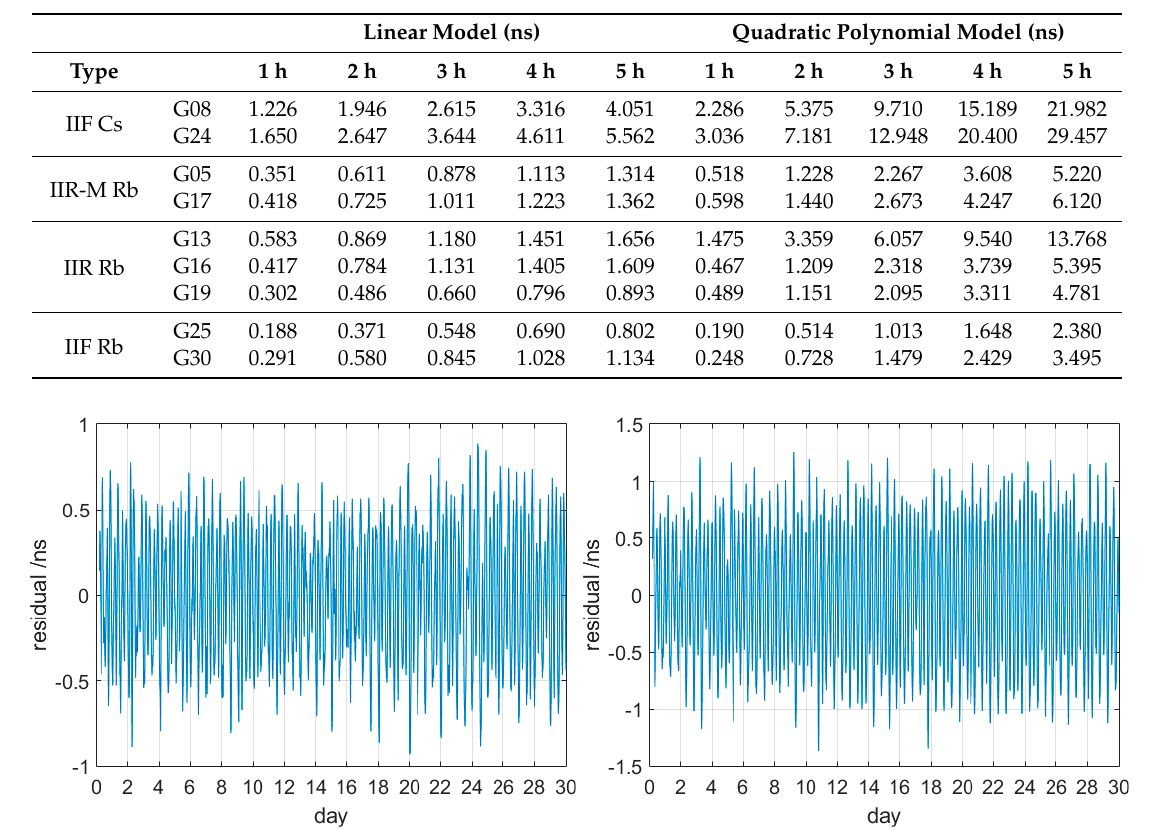
Figure 2. G25 and G30 prediction residuals for 2-h IGS final product.